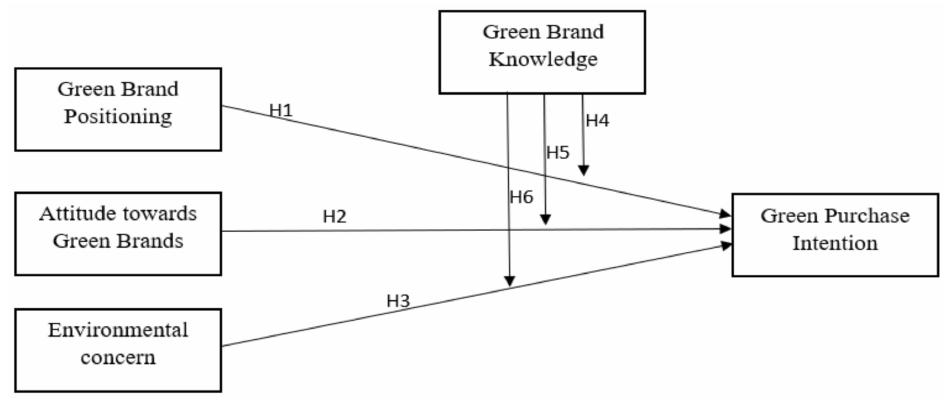
Figure 1. Conceptual